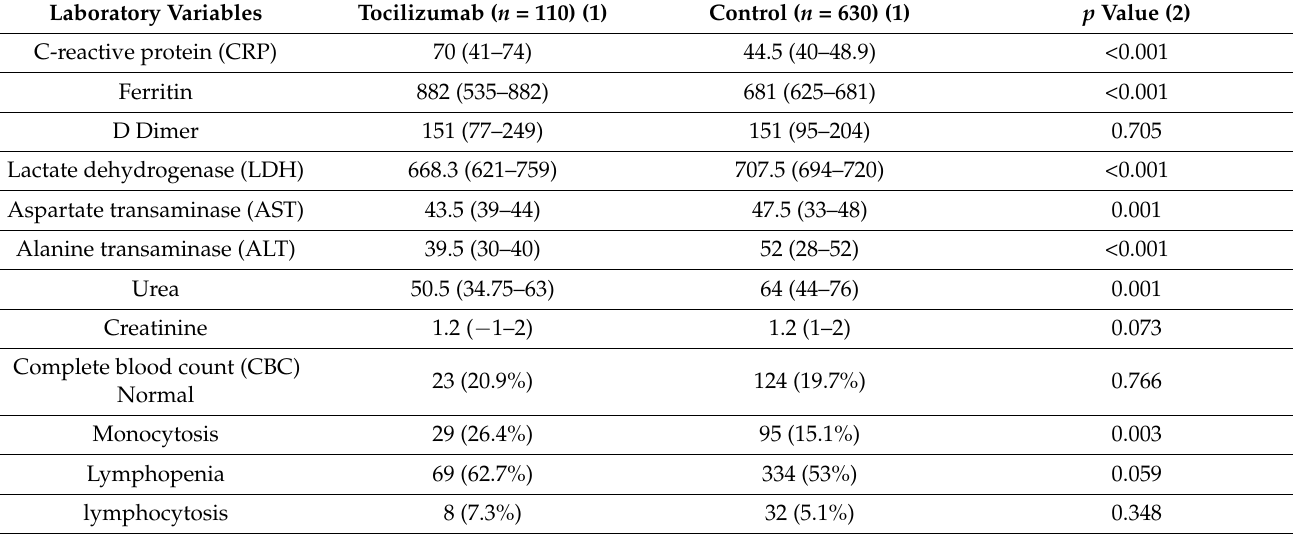
Table 2. Baseline laboratory variables of the study